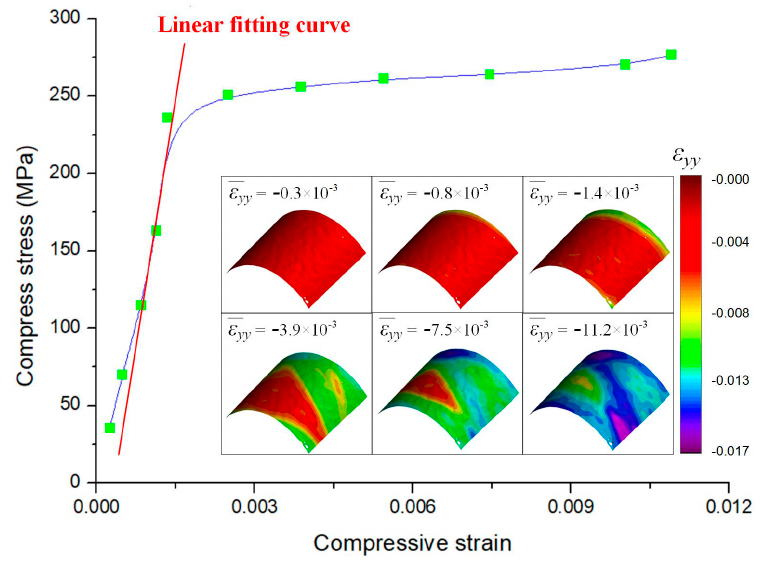
Figure 12. Stress–strain curve of the Q235 round bar specimen.